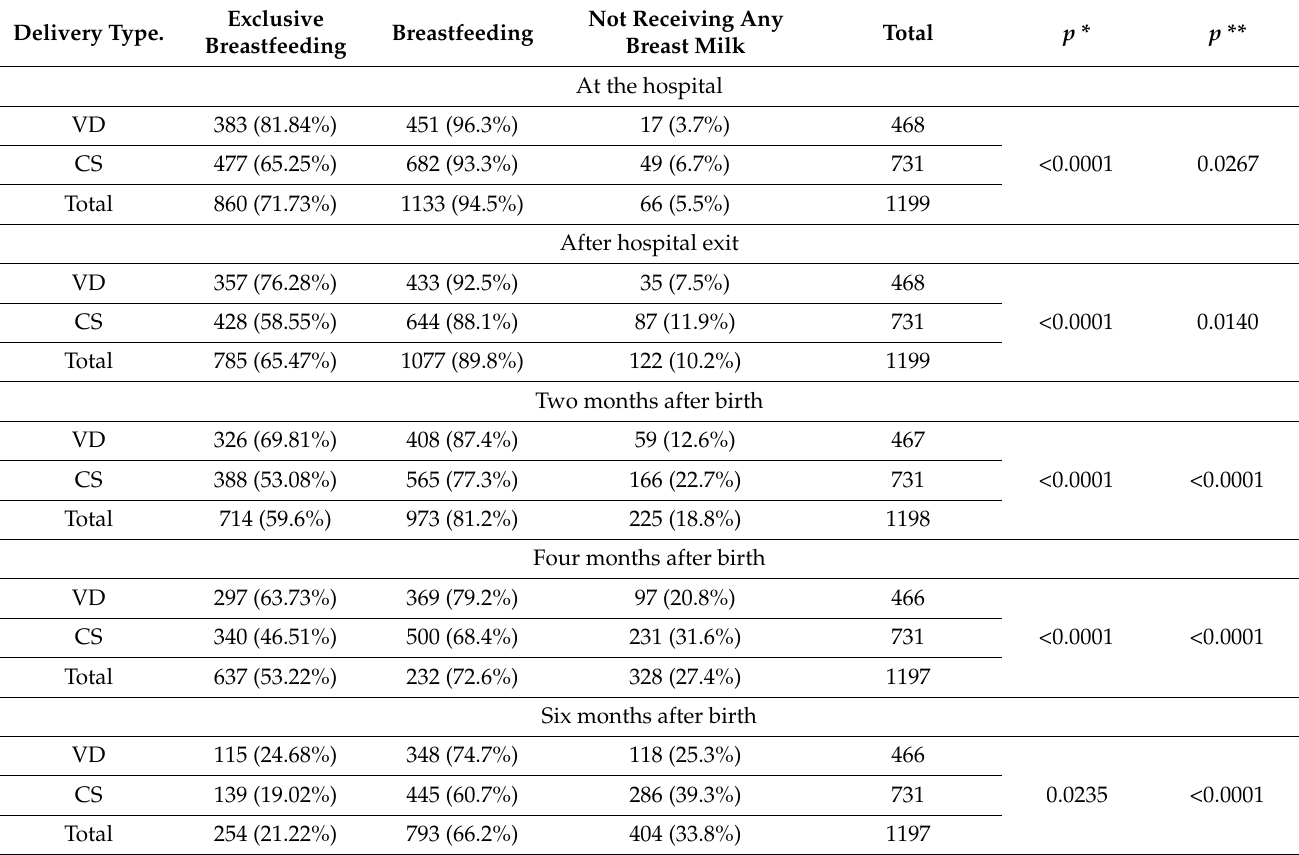
Table 3. The relationship between the mode of the delivery and the rates of the exclusive breastfeeding, the breastfeeding and the infants who did not receive any breast milk by infants’ age.